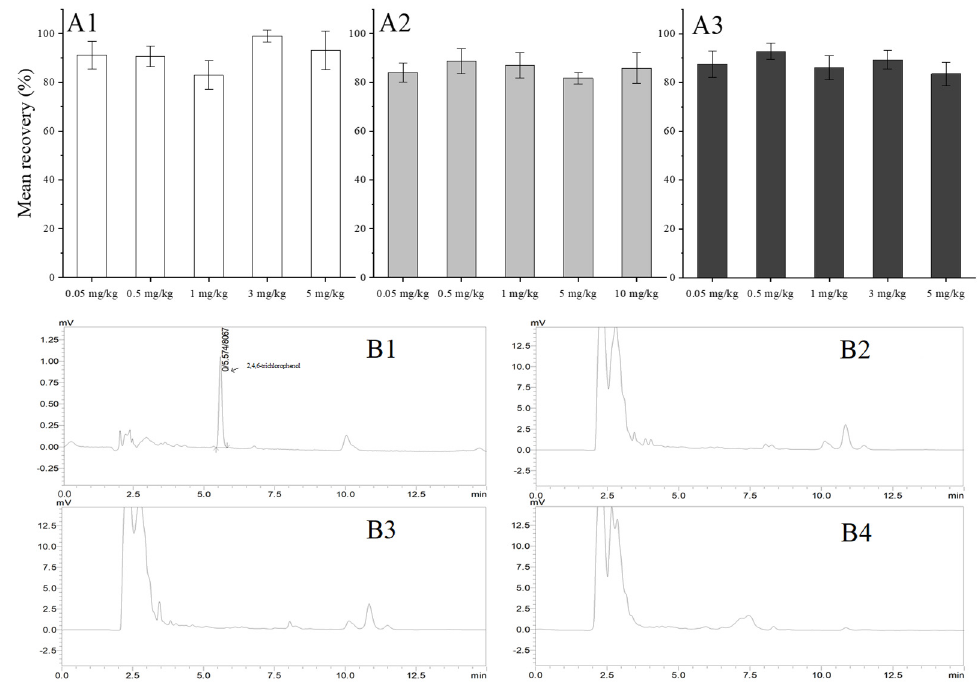
Figure 2. Mean recovery of 2, 4, 6-trichlorophenol in whole bananas ( A1 ), banana pulp ( A2 ) and banana peel ( A3 ) and the chromatgram of of a standard of 2,4,6-trichorophenol at 0.5 mg/kg ( B1 ), whole banana sample blank ( B2 ), banana peel sample blank ( B3 ), and banana pulp sample blank ( B4 ). Mean recovery ± RSD ( n = 5) are reported.